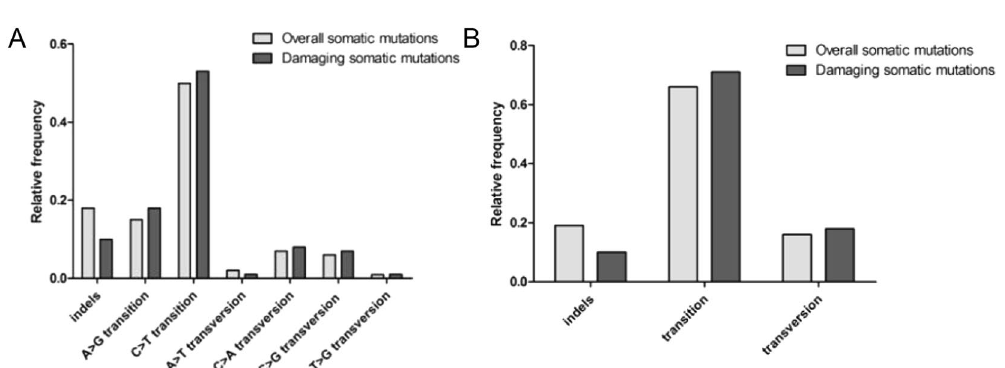
Figure 6. Relative frequencies of each type of nucleotide substitution ( A ) and of indels, transitions and transversions ( B ) among the overall somatic mutations and among the damaging somatic mutations detected in MUG-Mel 2 cell